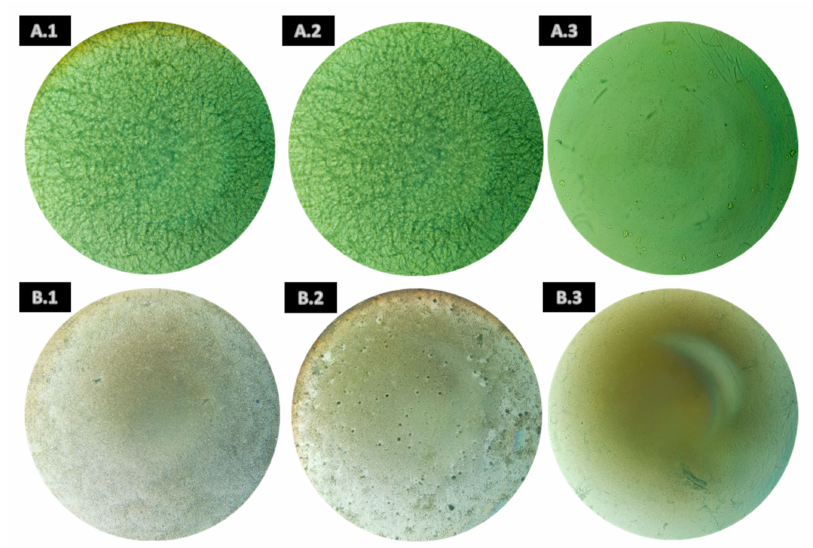
Figure 2. Representative examples of the spore germination minimum inhibitory concentration (MIC) of Fusarium oxysporum by the n -hexane, ethyl acetate, and ethanolic extracts of Asparagopsis armata . Where ( A.1 ): DMSO control (0.5 mg/mL); ( A.2 ): DMSO control (1 mg/mL); ( A.3 ): amphotericin B control (2 µ g/mL); ( B.1 ): n -hexane (0.5 mg/mL); ( B.2 ): ethyl acetate (0.5 mg/mL); and ( B.3 ): ethanol (1 mg/mL).